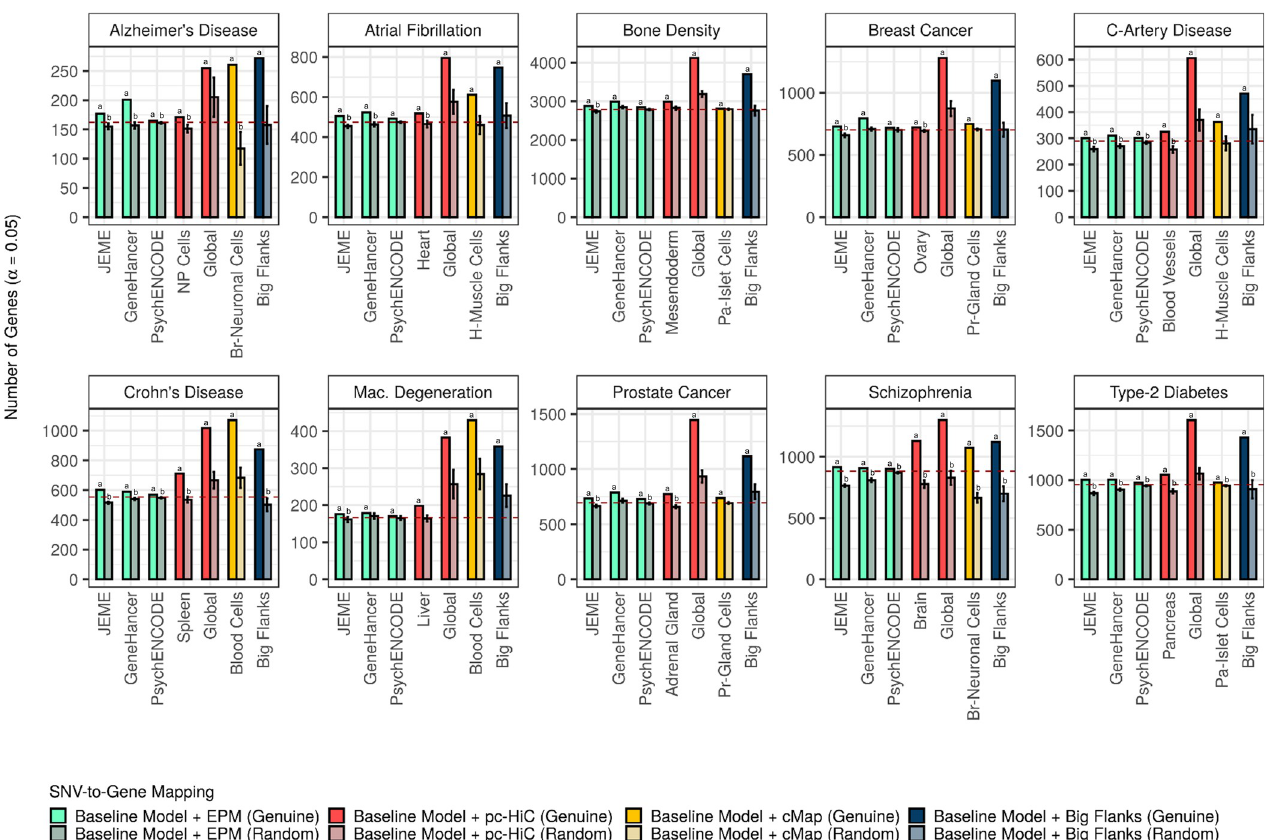
Fig 3. Genuine augmentations are associated with more significant genes than matched, random augmentations. The number of significant genes detected for selected, genuine augmentations (saturated bars), in comparison to matched, random augmentations (desaturated bars). For random augmentations, counts and error bars represent the mean and standard deviation, respectively (based on 20 independent permutations of EPVP). Red, dashed line shows the number of significant genes detected with the baseline model itself. We tested (T-test) if there were more significant genes with genuine augmentation than with matched, random augmentation ( a above a saturated bar indicates that the p -value of the test, which was FDR-adjusted across all mappings within each phenotype, was smaller than 0.05). We then tested, in a similar way, if there were more significant genes with the baseline model than with random augmentation of the baseline model ( b above a desaturated bar for an FDR-adjusted p -value smaller than 0.05). The augmentation, “Big Flanks”, refers to gene bodies with 100kb upstream- and downstream flanks (note, as part of the baseline model, the first 10kb on either side of a gene body were not permuted by EPVP). Phenotype abbreviations: C-Artery Disease (coronary-artery disease); Mac. Degeneration (macular degeneration). Mapping abbreviations: Br- Neuronal Cells (brain-neuronal cells); H-Muscle Cells (heart-muscle cells); NP Cells (neural-progenitor cells); Pa-Islet Cells (pancreatic-islet cells); Pr-Gland Cells (prostate-gland